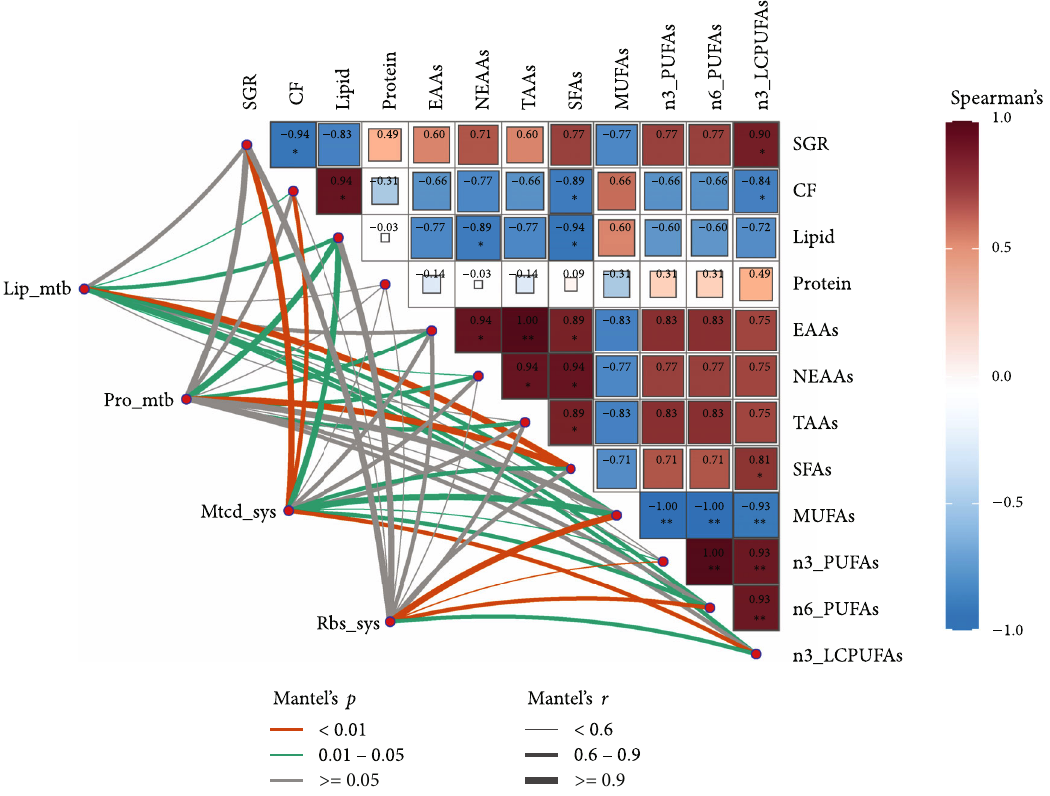
Figure 4: Multidimensional correlation analysis between gene expression and larval nutrition parameters. Nutritional parameters: speci fi c growth rate (SGR); larval body lipid, protein, and essential amino acid (EAA) contents; nonessential amino acid (NEAA) content; total amino acid (TAA) content; saturated fatty acid (SFA) proportion monounsaturated fatty acid (MUFA) proportion; n-3 polyunsaturated fatty acid (n3_PUFA) proportion; and n-6 polyunsaturated fatty acid (n6_PUFA). Gene expression: liver tissue protein metabolism- related genes (Pro_mtb), lipid metabolism-related genes (Lip_mtb), mitochondria synthesis-related genes (Mtcd_sys), and ribosome synthesis-related genes (Rbs_sys) are listed in Table 6. Nutritional parameter comparisons in pairs are shown, with Pearson ’ s correlation coe ffi cients indicated by a color gradient and color block size. Mantel ’ s tests show a correlation between related gene expression levels and de fi ned factors. Mantel ’ s r statistic and Mantel ’ s p statistic for the relevant distance correlations, respectively, are represented by edge width and